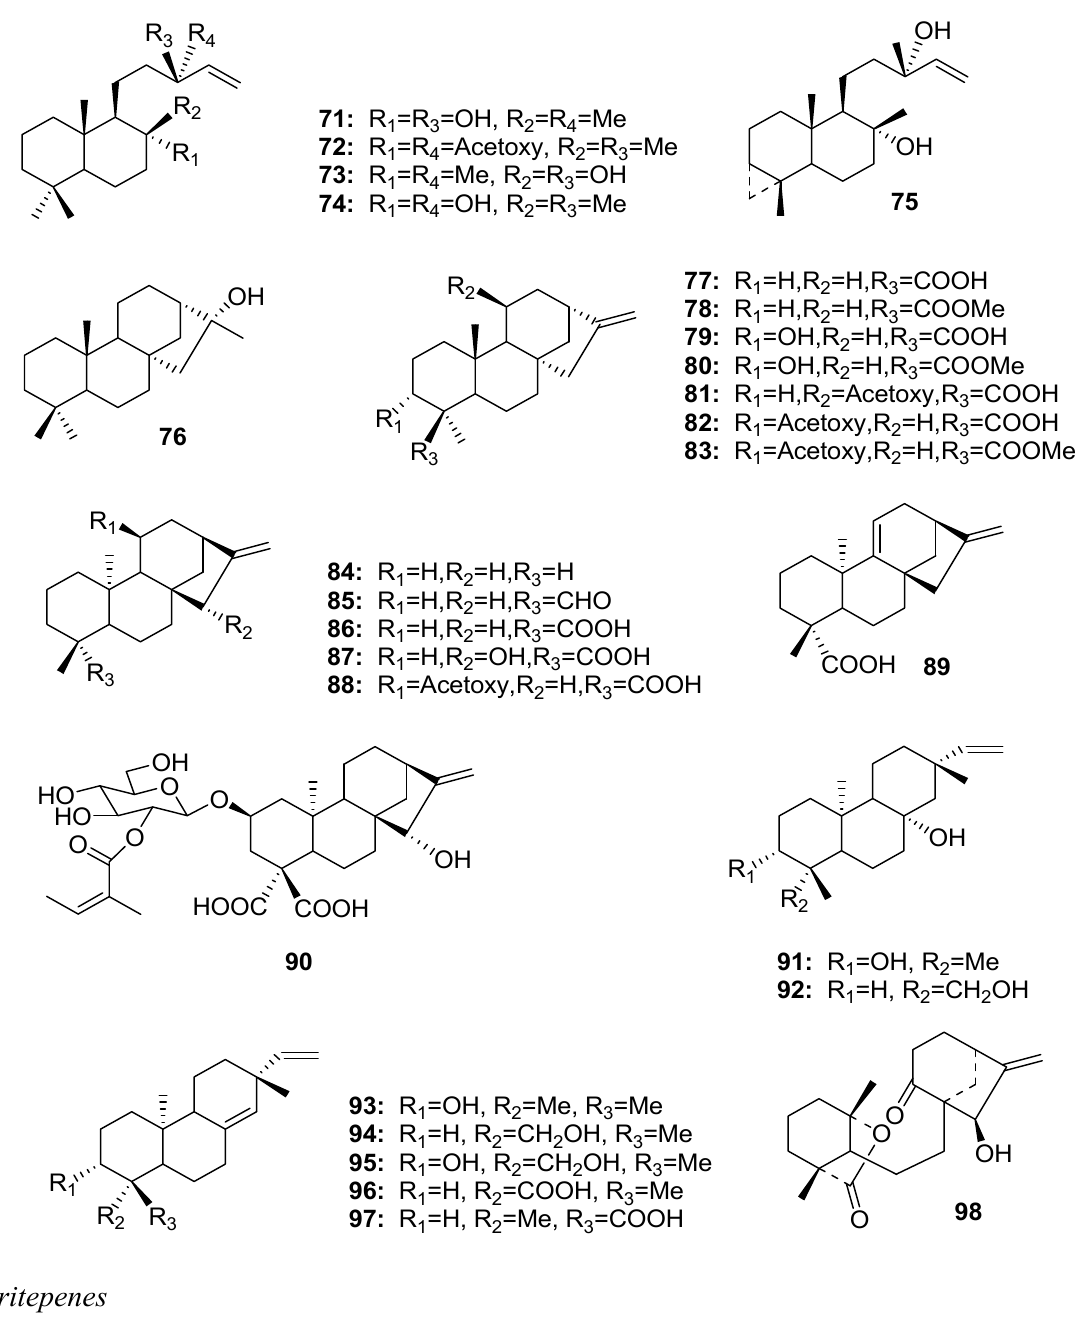
Figure 3. Chemical structures of diterpenes isolated from the genus Gnaphalium